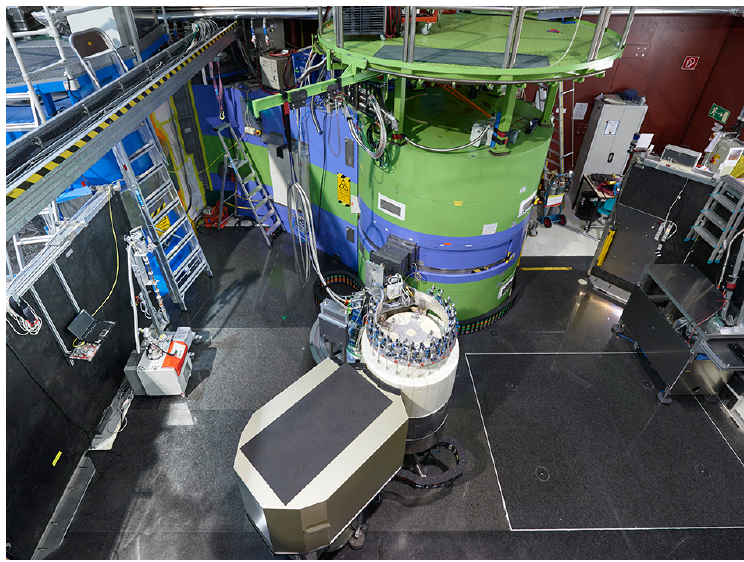
Figure 1: Instrument PANDA (Copyright by W. Schürmann,